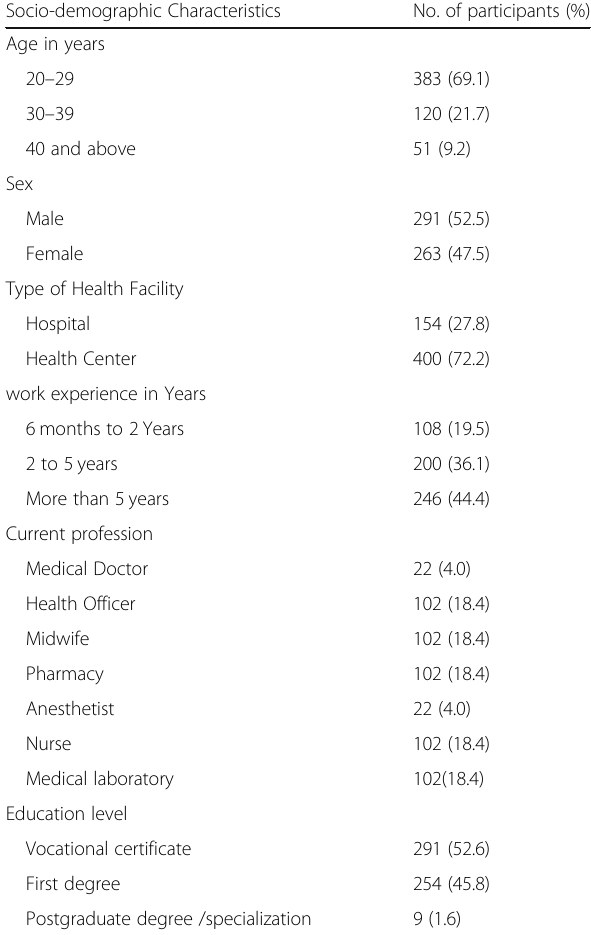
Table 1 Socio-demographic characteristics of study participants, exploring health workforce regulation practices and gaps, Ethiopia, 2015 ( N = 554) Socio-demographic